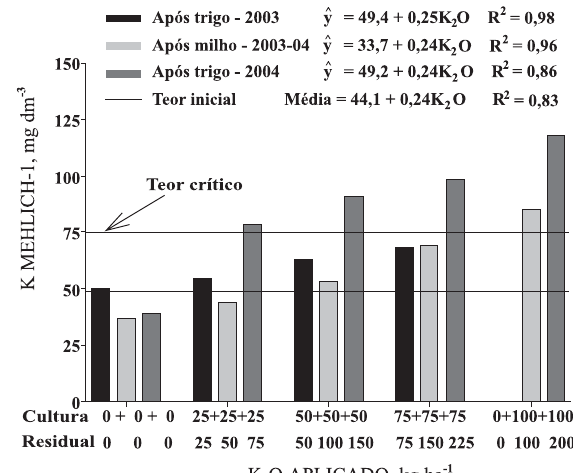
Figura 2. Teor de K extraído por Mehlich-1 em três épocas, e equações de resposta do solo à aplicação de K na sucessão trigo/milho/trigo no experimento